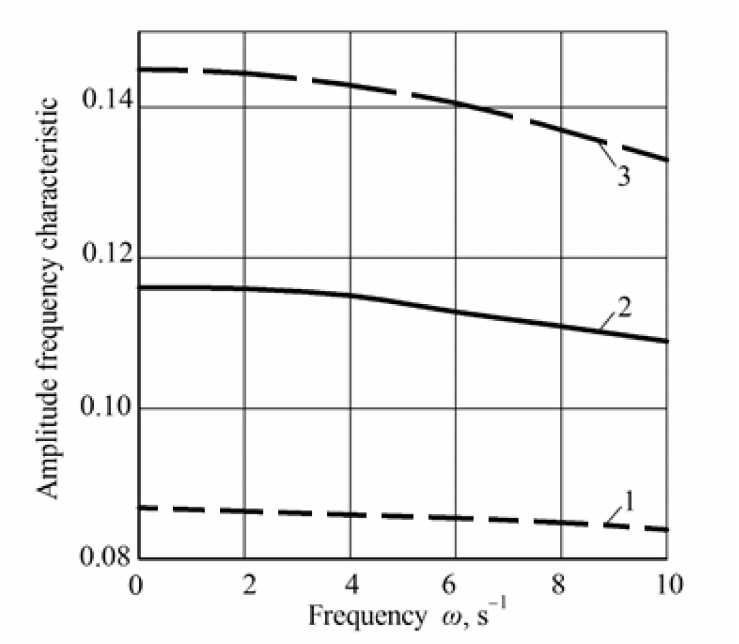
Figure 4. Amplitude-frequency characteristic of the tractor course angle ϕ when working out perturbations by it in the form of oscillations of the haulm harvester’s steering angle β at various